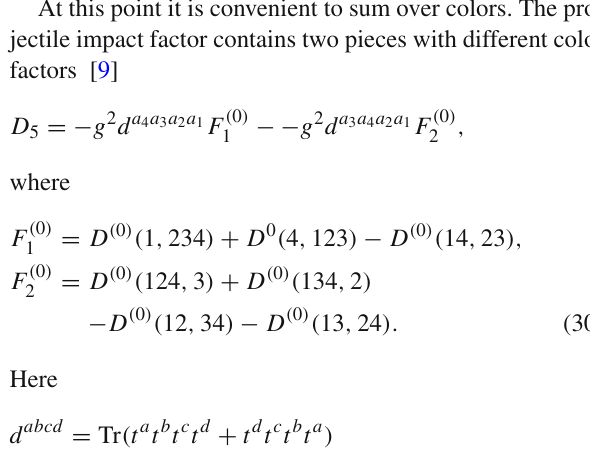
The integration over q 2 + in Fig. 7a, d is done due to the cut (cid:6) − e ) 2 . One gets factor − 1 / 2 | e − | ( q which provides − 2 πδ 2 and puts q 2 + = − p 2 ⊥ / 2 e − < 0.The integration over q 1 + in Fig. 7b, c is done using − 2 πδ . One gets the same factor − 1 / 2 | e − | and puts q 1 + = p 2 ⊥ / 2 e − > 0. There are no additional longitudinal